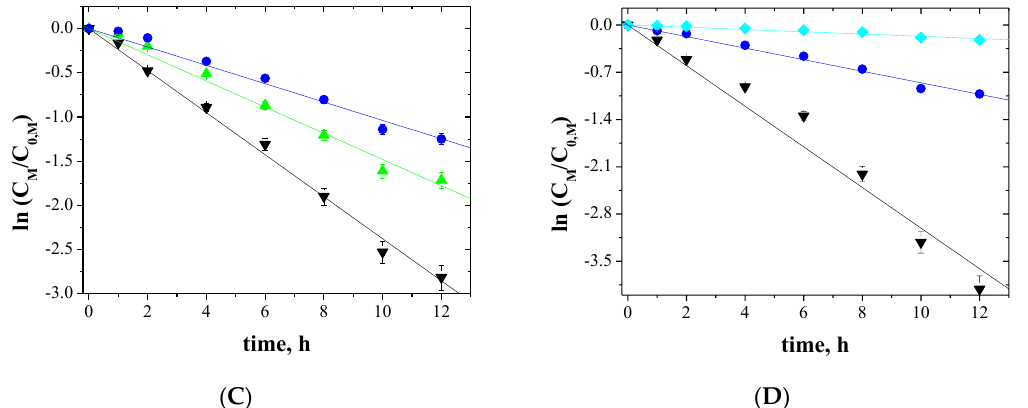
Figure 7. Kinetics of the transport across PIMs containing EDAB-acac for 3-component mixture of (cid:72) -Zn(II), (cid:4) -Co(II), and (cid:7) -Ni(II) ( A ); (cid:72) -Zn(II), (cid:4) -Co(II), and • -Cu(II) ( B ); (cid:72) -Zn(II), (cid:78) -Cd(II), and • -Cu(II)